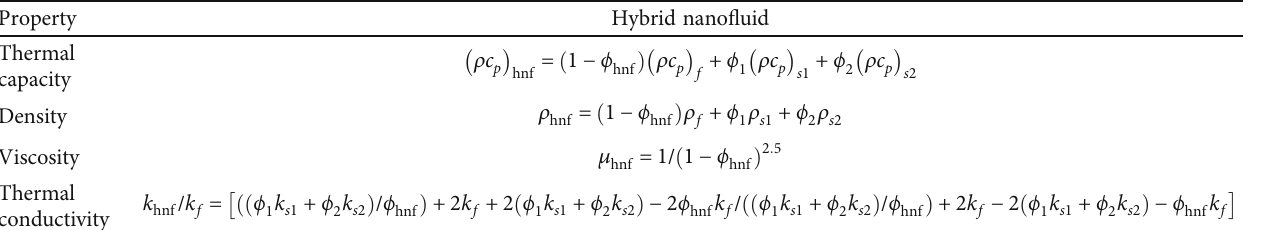
Table 2: Applied models for thermophysical properties of the hybrid nano fl uid [4].